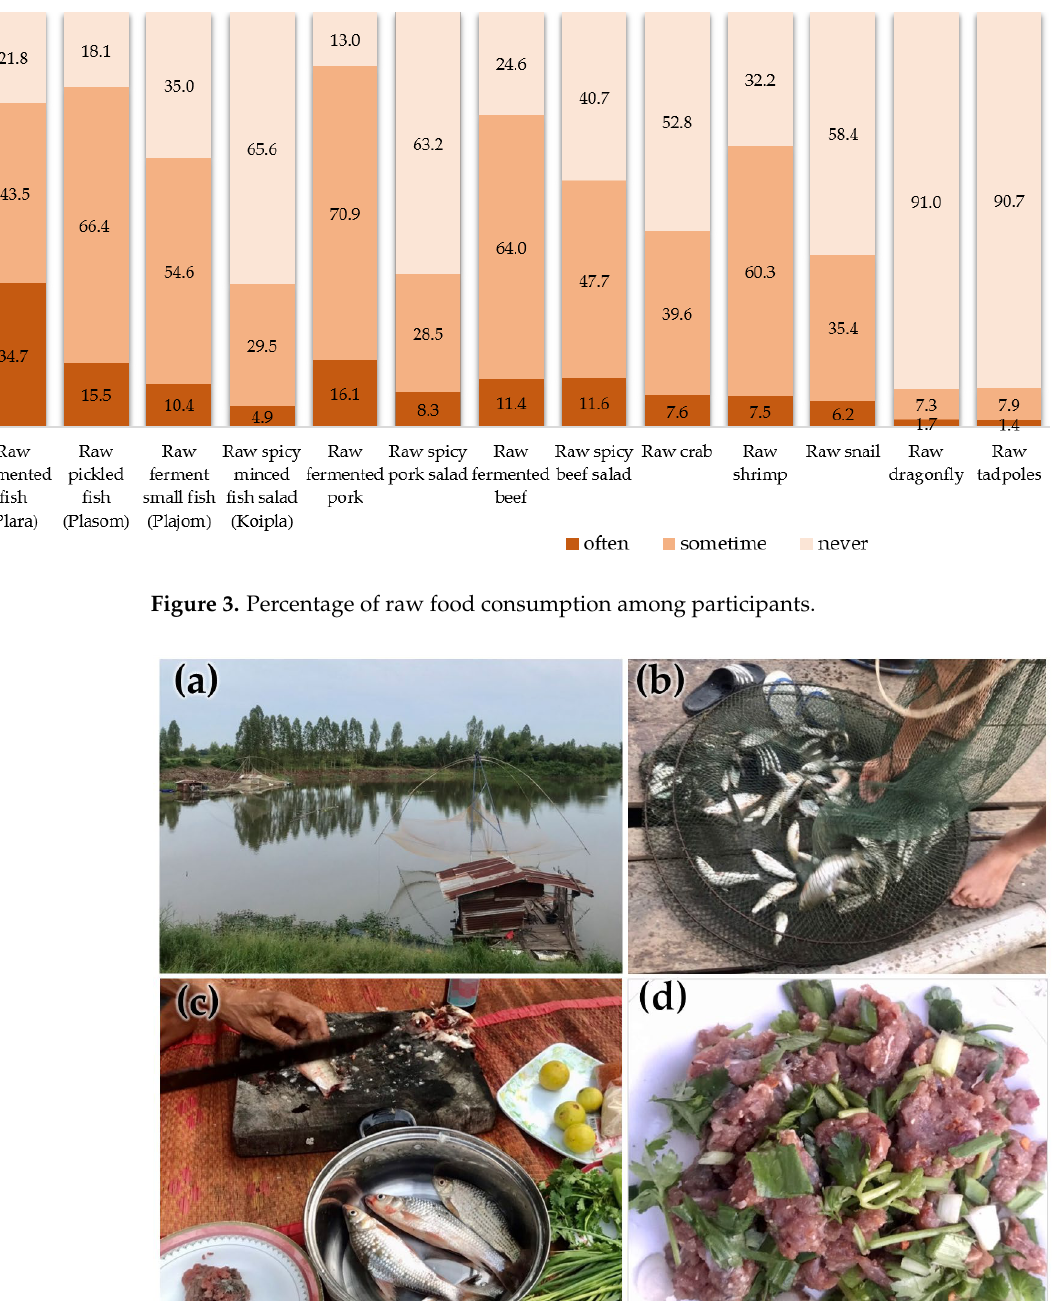
Figure 4. ( a , b ) The community located along the river where people fished for a living; ( c , d ) the traditional raw or improperly cooked fish consumption in this area.